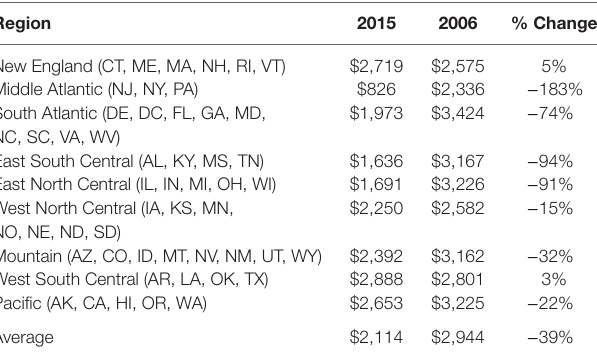
Table 6 | Comparison of 2006 and 2015 reimbursement averages by region. region